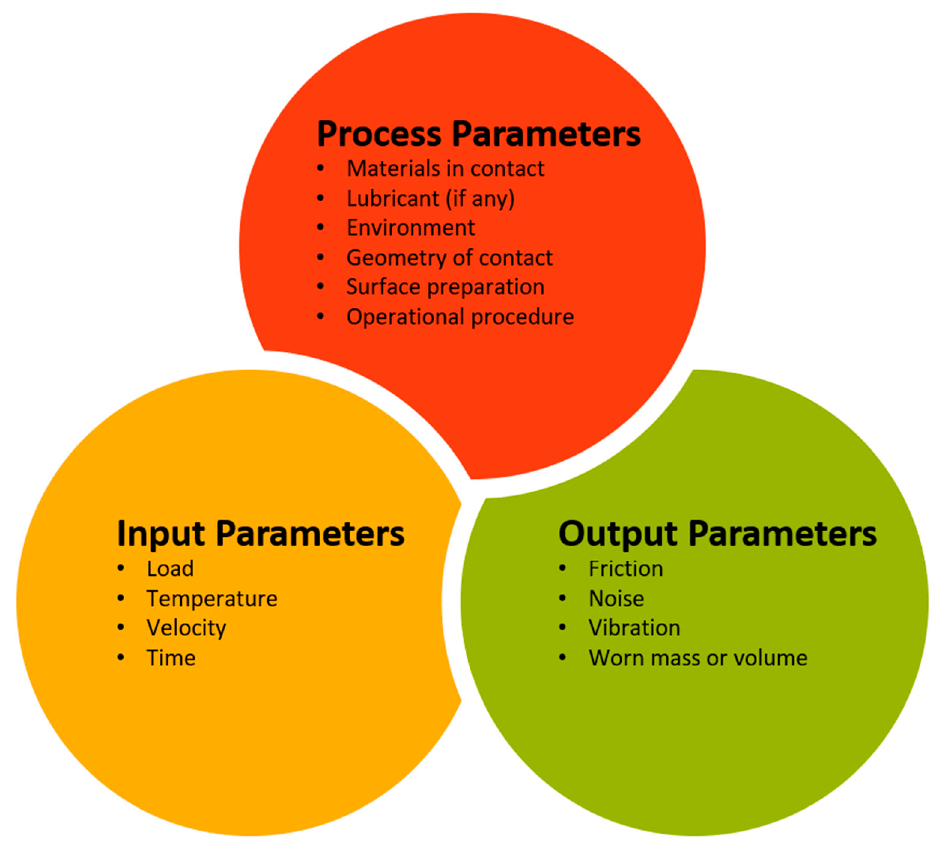
Figure 14. Schematic representing factors influencing the wear process. Tribology is the branch of science that deals with friction and wear, concerning inter- acting bodies with relative motion. Friction refers to the resistance to movement that oc- curs as a solid body moves tangentially in contact with and across the surface of another body. Friction is thus a system response in the form of a reaction force rather than a ma- terial property. The process of material removal from moving surfaces in contact with